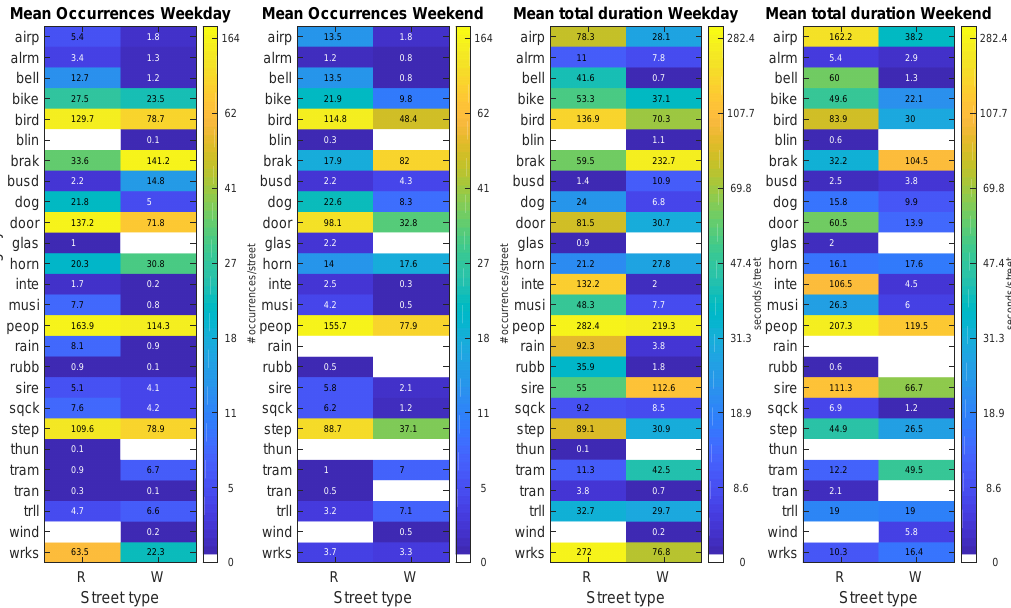
Figure 6. Results of the narrow–wide analysis ( P RW matrices) differentiating weekday and weekend days for the following ANE features: mean number of occurrences per street (two leftmost subfigures) and total duration per street (two rightmost figures). Each subfigure shows the distribution of the corresponding ANE feature in terms of ANE subcategory and type of street where the sensor is